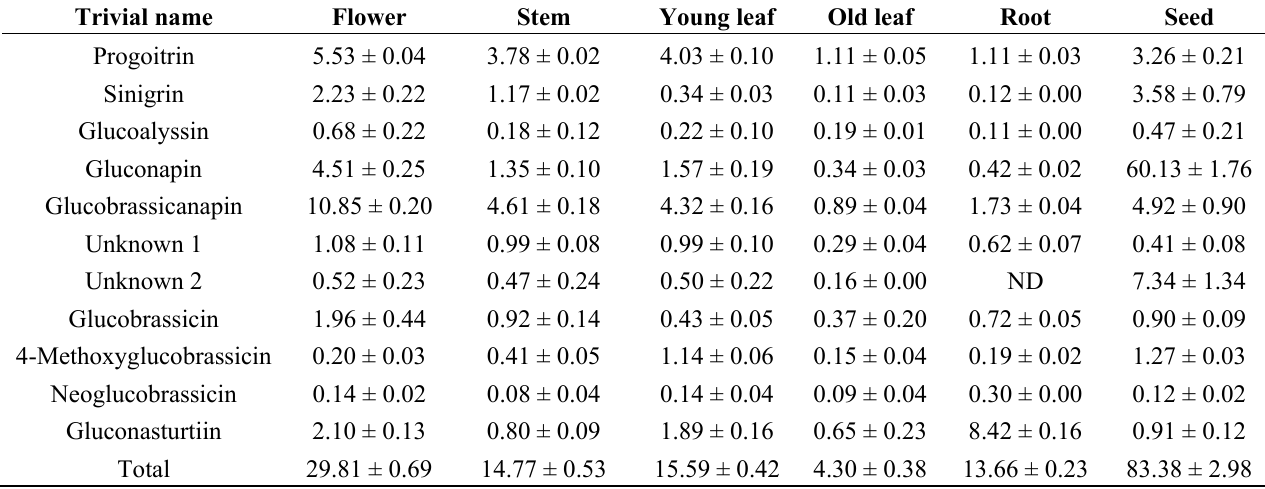
Table 3. Glucosinolate content (µmol/g DW) in different organs of Chinese